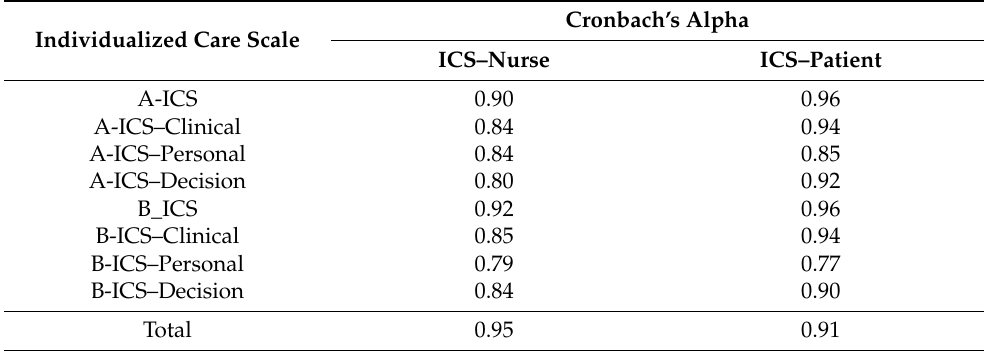
Table 1. Reliability statistics for the Lithuanian version of the Individualized Care Scale–Nurse Version (ICS–Nurse) and Patient Version